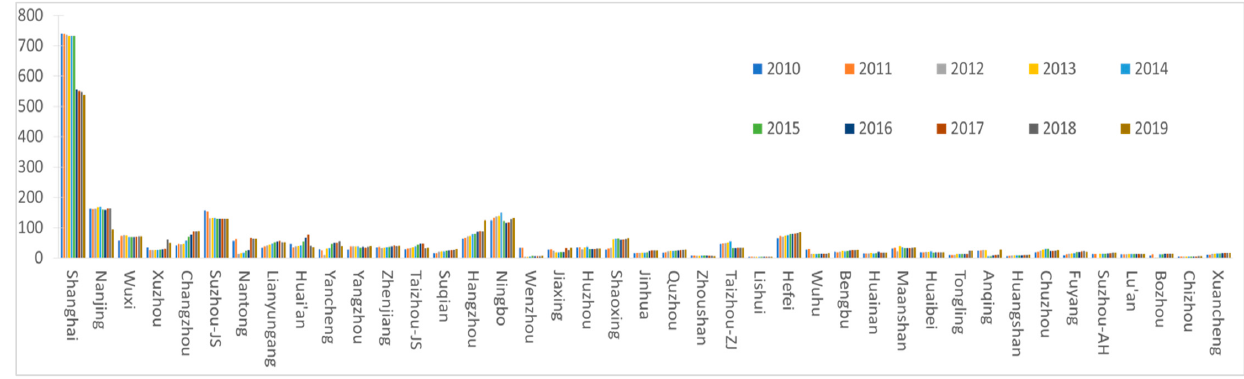
Figure 5. Change analysis of urban industrial land in the YRD.